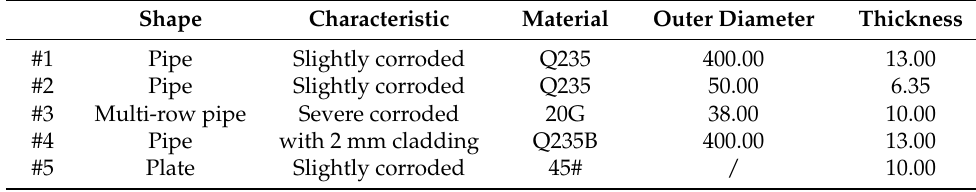
Table 1. Specimen parameters (unit: